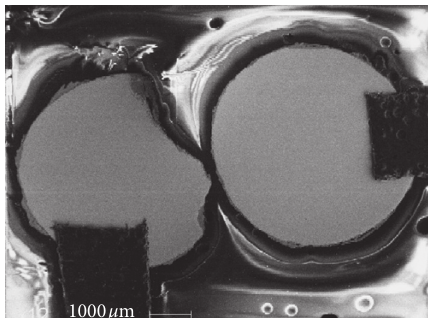
Figure 10: Low-power images of metallographic samples of the transverse section of the steel strand with and without pit